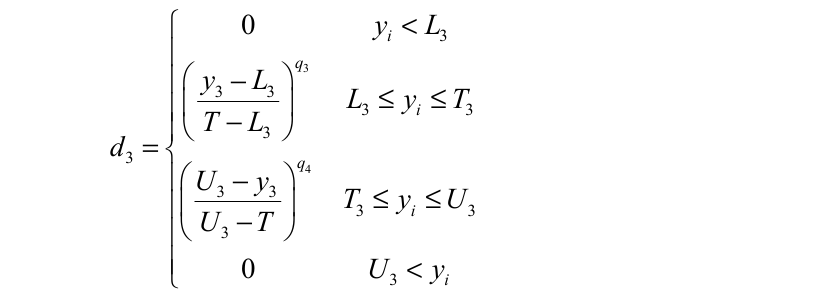
Figure 5. Response surfaces of the ( a ) surface FOM, ( b ) S/B ratio, ( c ) FWHM, and ( d ) overall desirability for the design factors of h